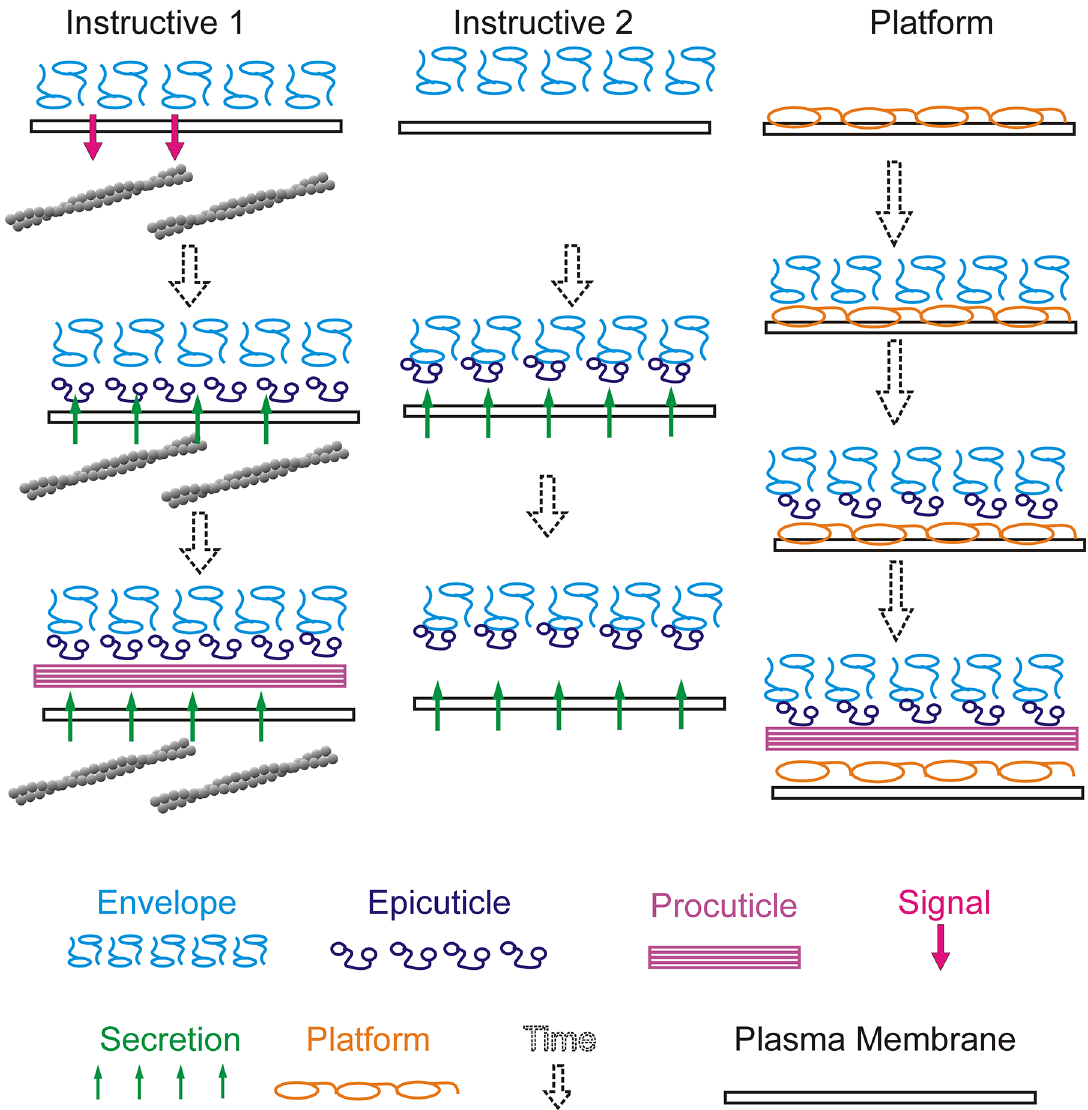
Fig 8. Models to explain the procuticle phenotypes of 42 hr genes. In the Instructive 1 model the 42 hr proteins form the envelope, which signals back to the cell to organize the cytoskeleton so that the epicuticle and procuticle is secreted in the proper pattern. In Instructive 2 the 42 hr proteins form the envelope and when the proteins that form the epicuticle are secreted they bind to and are patterned by envelope and 42 hr proteins. A similar situation could result in the epicuticle patterning the procuticle. In the Platform model the 42 hr proteins are not part of the envelope but they form a complex that is essential for the patterned secretion of the proteins that form the 3 cuticular layers. Our second model is that many of the 42 hr genes do not encode proteins that are part of the envelope. Rather they would form a “ platform ” or complex that in some way mediates the tight juxtaposition of the cuticle and the apical surface of the epithelial cells and that this platform is needed for the proper deposition of the envelope and other cuticular components